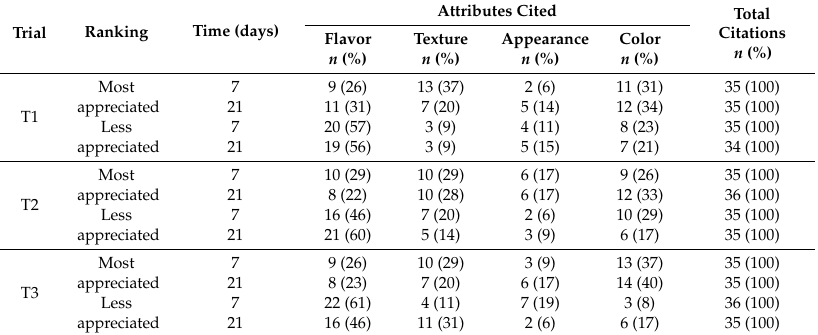
Table 6. Sensory attributes cited as “most appreciated” and “less appreciated” by the judges ( n = 35) for of fermented dairy dessert trials containing jabuticaba peel ingredients on Days 7 and 21 of